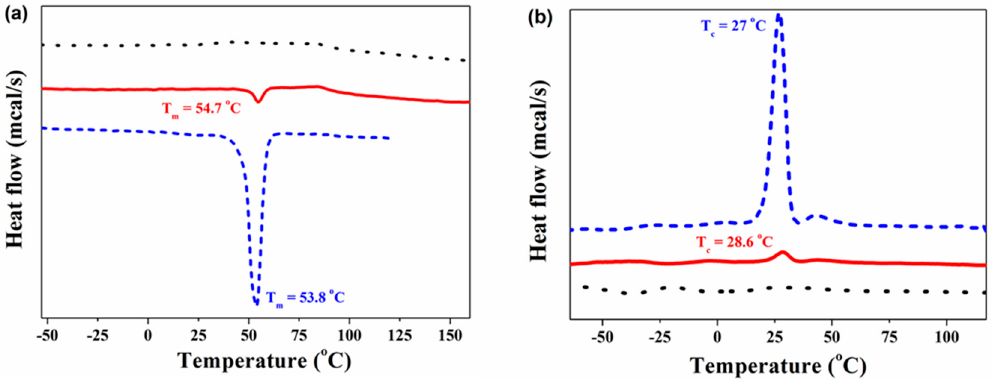
Figure 4. DSC thermograms of CS ( · · · ), PCL-COOH (– – –), and CS- g -PCL (—). The second heating cycle ( a ) and the cooling cycle ( b ).